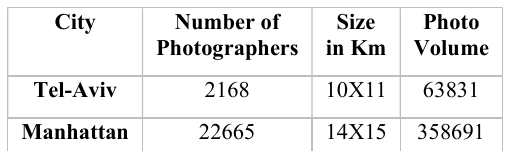
Table 1. Main Flickr photo data statistics for Tel-Aviv and